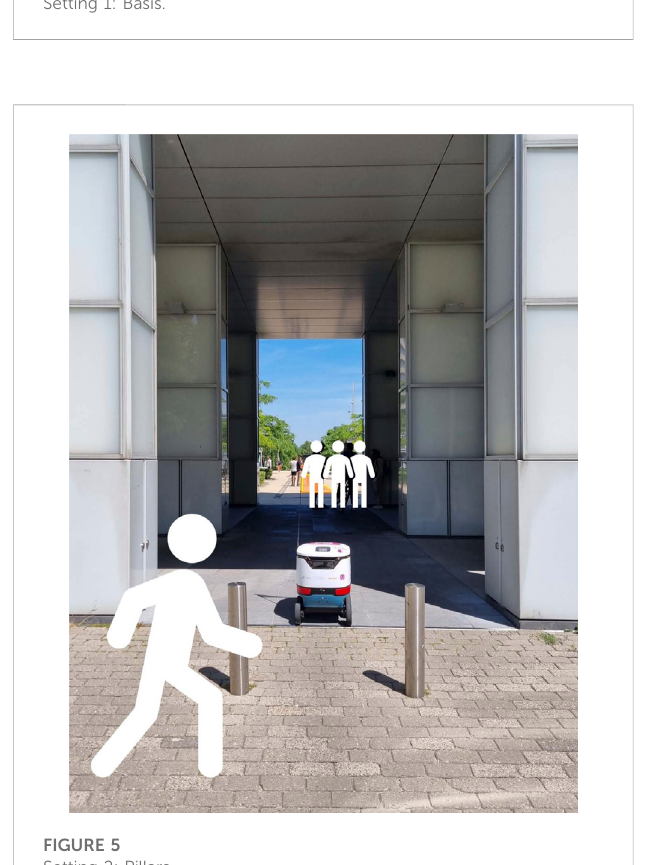
FIGURE 4 Setting 1: Basis.